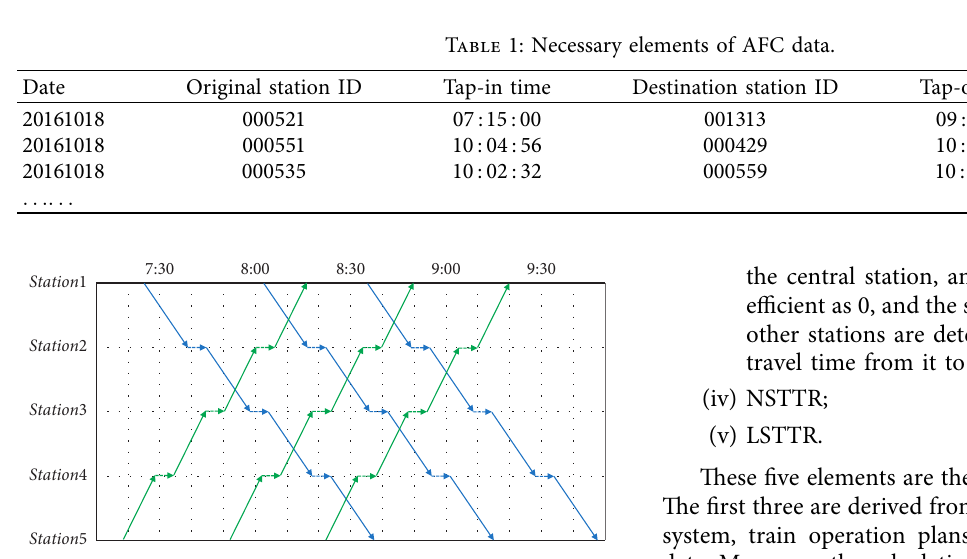
Figure 1: Example of actual train